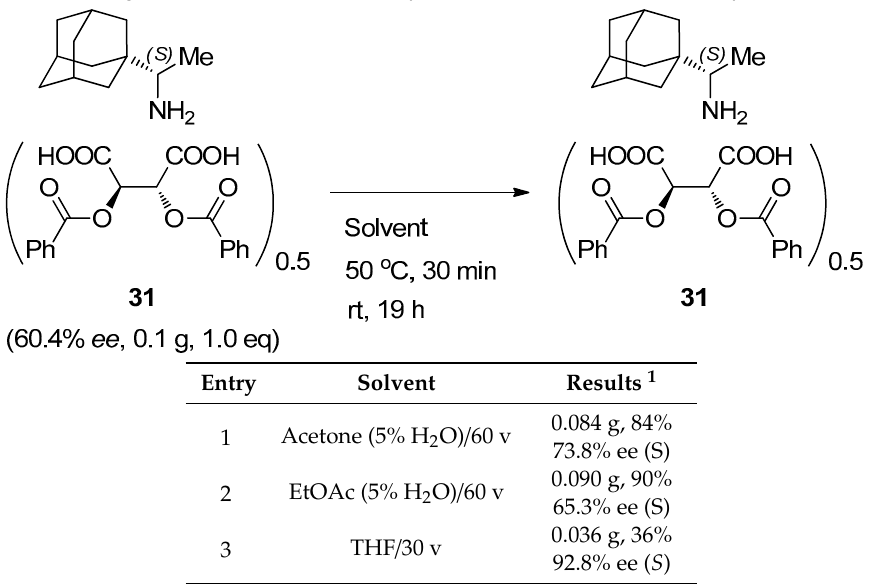
Table 3. Screening of solvent for the second crystallization of diastereomerically enriched salt 31 .